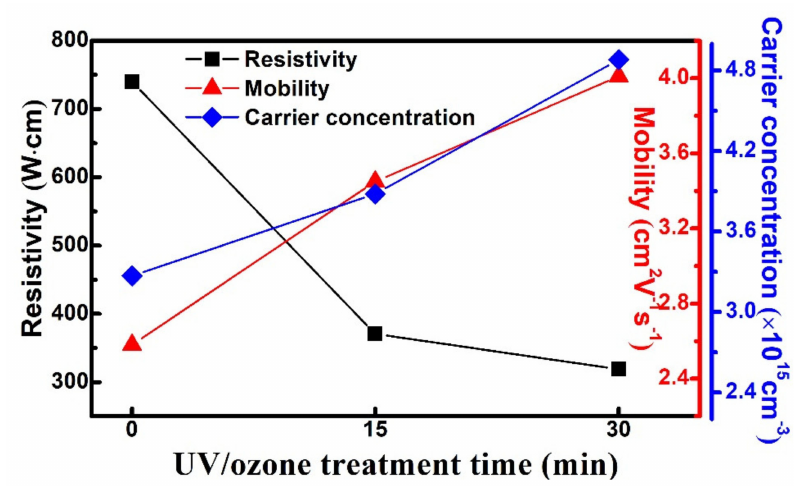
Figure 4. Resistivity, hall mobility, and carrier concentration of Ga 2 O 3 films deposited on 4H-SiC at different UV/O 3 treatment times.